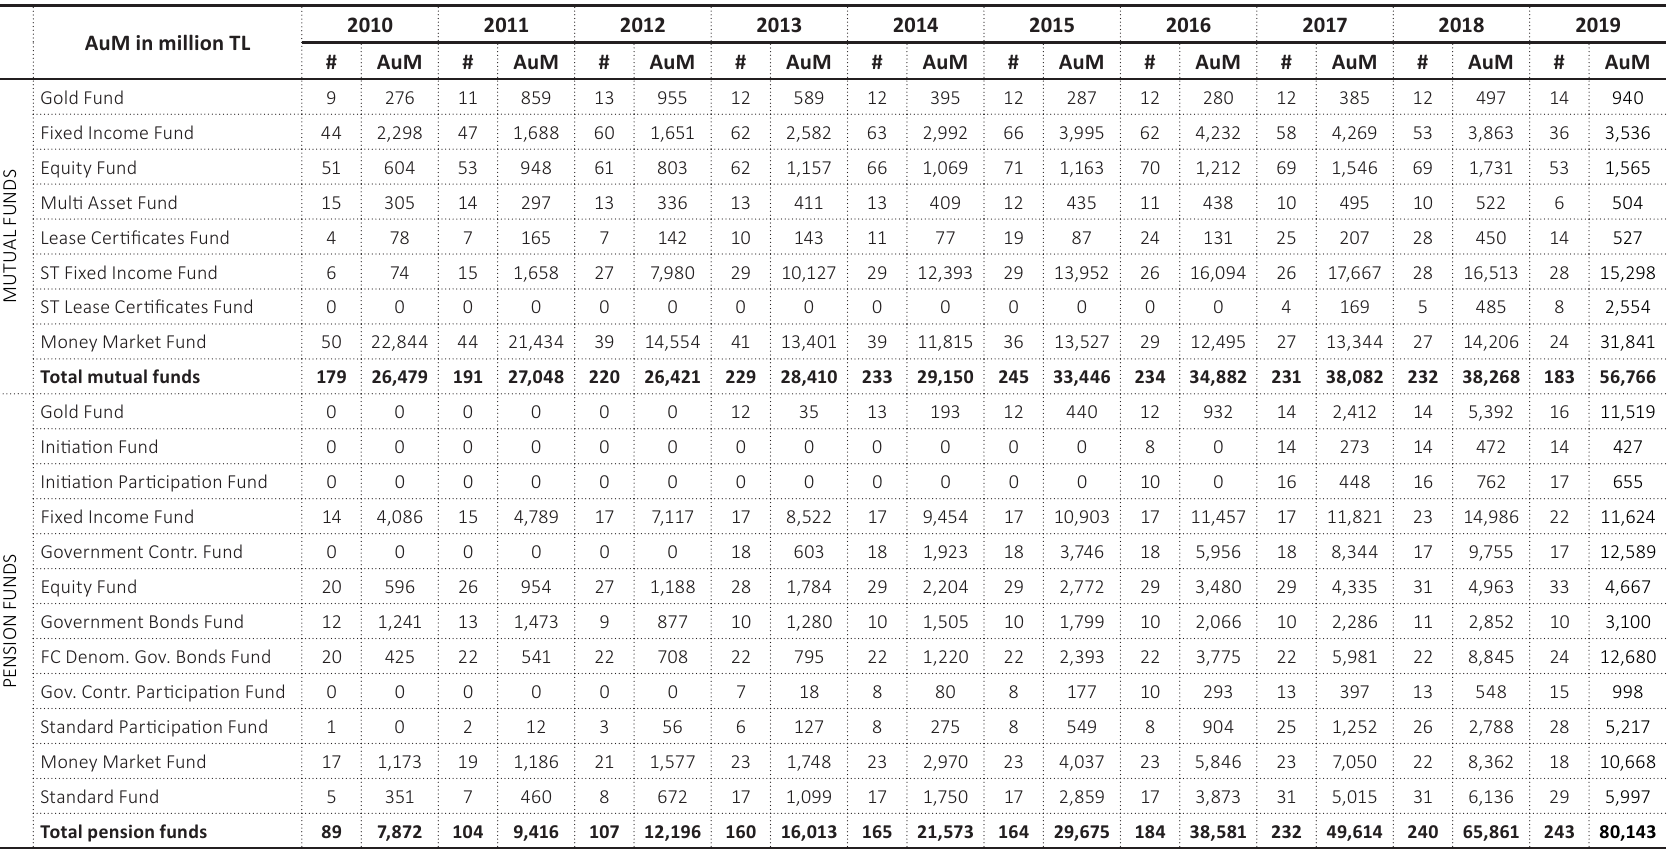
Table 1. Categories of both mutual and pension